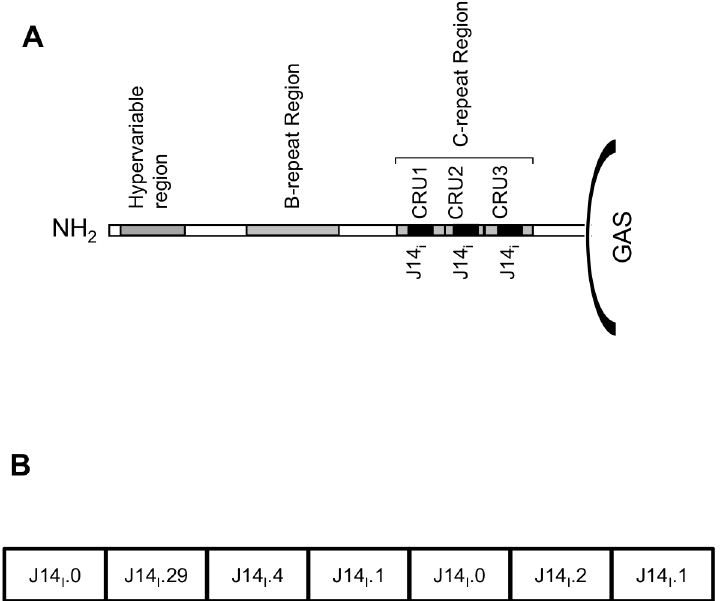
Fig 1. (A) Schematic diagram of the M-protein . The hypervariable region, B and C-repeat regions (CRR) and C-repeat units (CRUs) are depicted. The location of J14 i variant peptide sequences within each of the CRUs are shown as black boxes. The figure is not drawn to scale. (B) Schematic of SV1 . The location and identity of each J14 i sequence is shown.